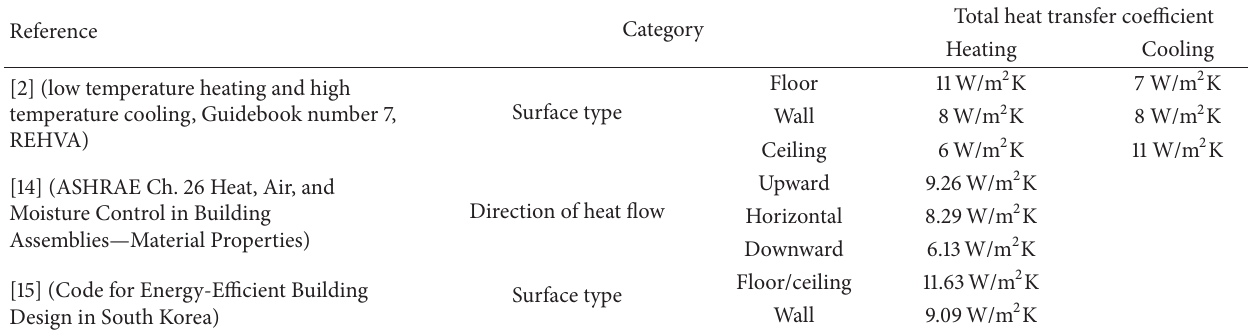
Table 6: Surface heat transfer coefficients from [2, 14,